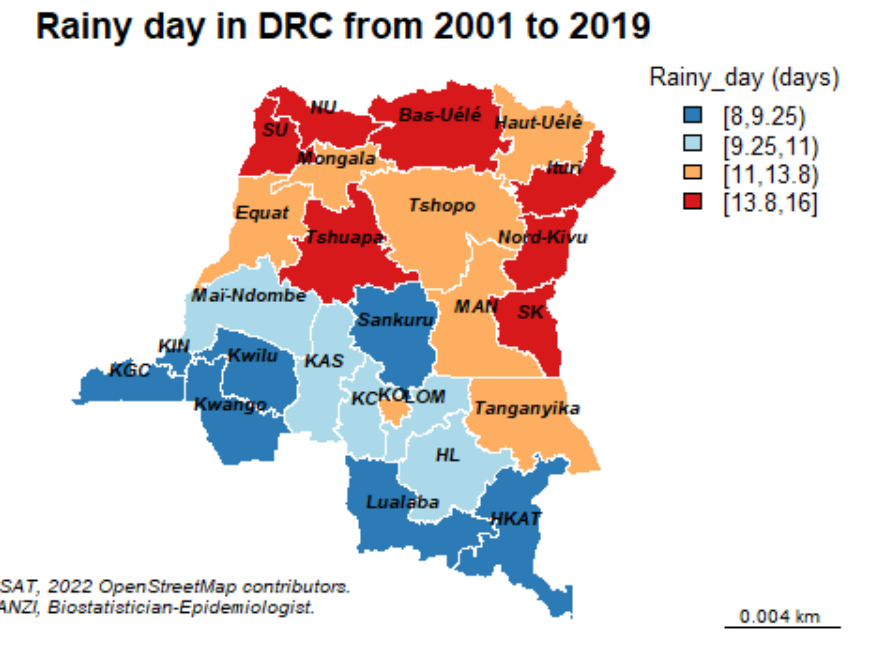
Figure 1. Map of the DRC showing the 26 administrative provinces with average number of YEARLY rainy days between 2001 and 2019 obtained from the National Geographic Institute of the DRC.